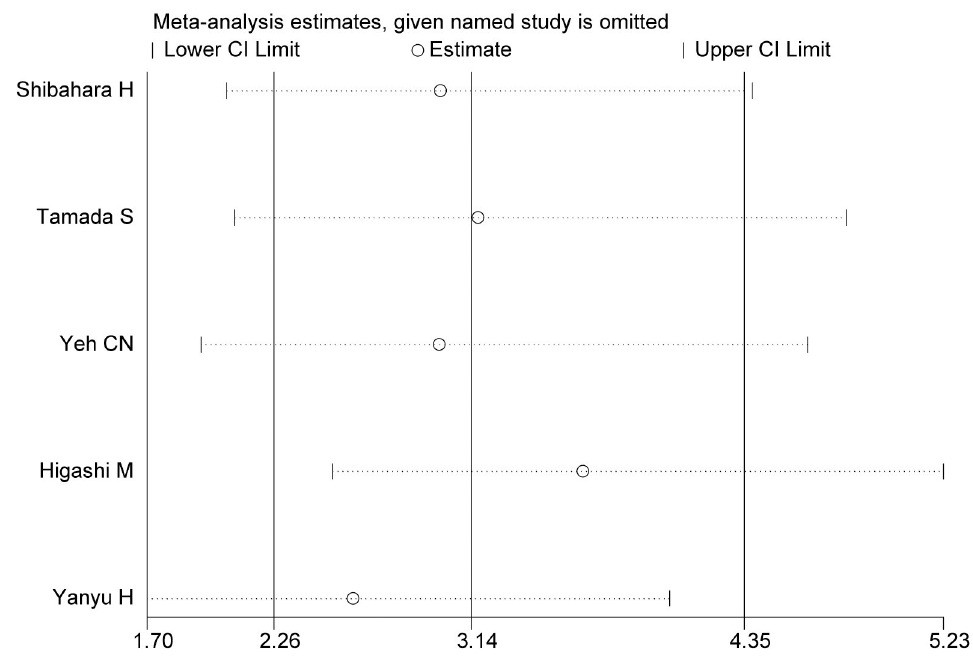
Fig 3. Result of sensitivity analysis. The middle vertical line indicates the combined HR, and the two vertical lines represent the corresponding 95% CI values. The middle small circle and two ends of the dotted lines indicate the pooled HR and 95% CI values, respectively, when the study on the left was omitted after each round of